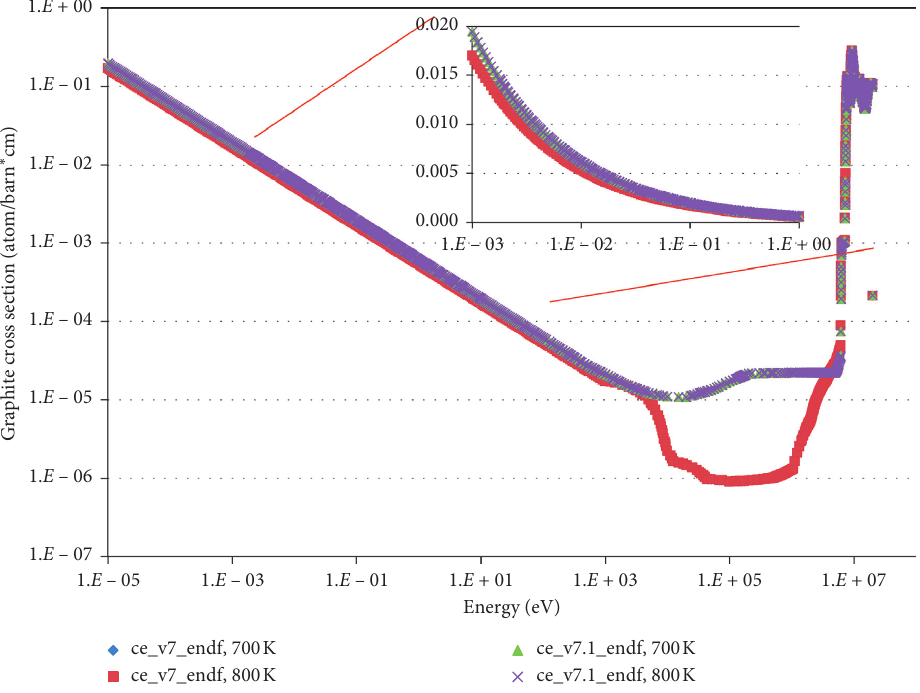
Figure 13: Neutron absorption cross sections in the whole energy